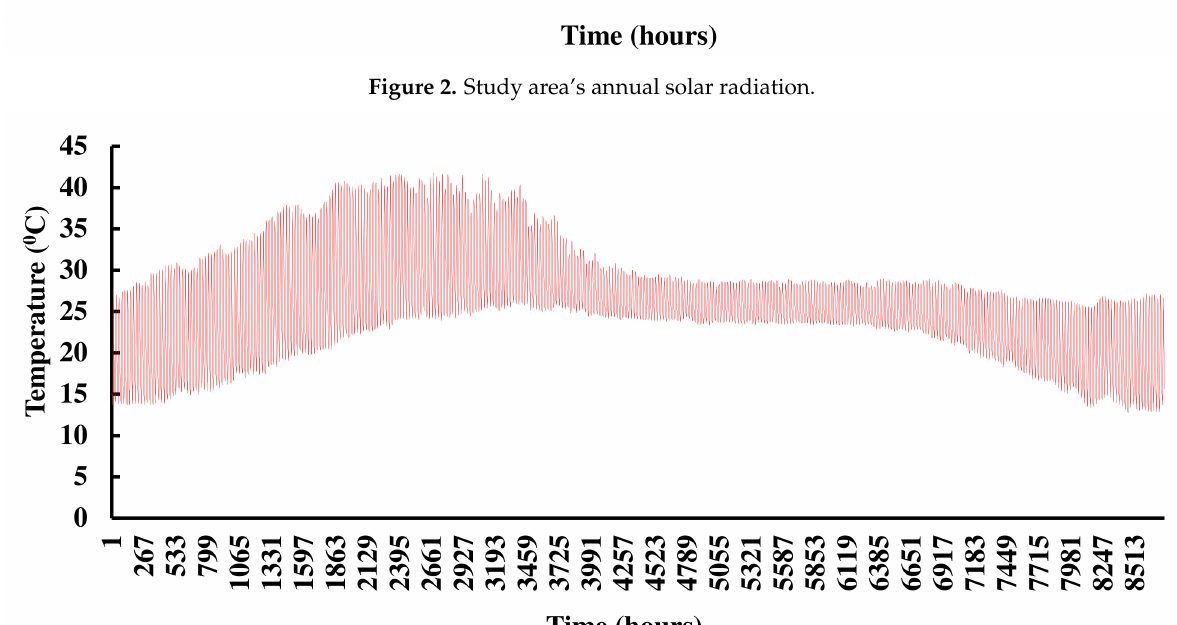
Figure 2. Study area’s annual solar radiation.